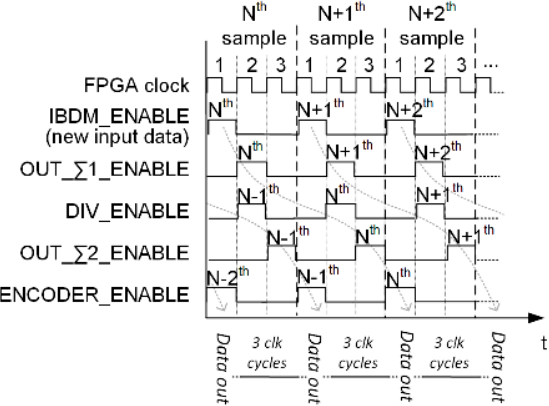
Figure 12. Pipelined controller unit enable signals time diagram.